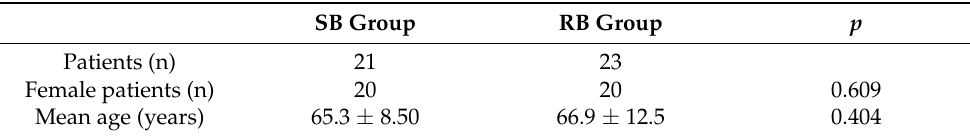
Table 1. Demographic data of the Spot Break (SB) Group and Random break (RB) Group DE patients in the